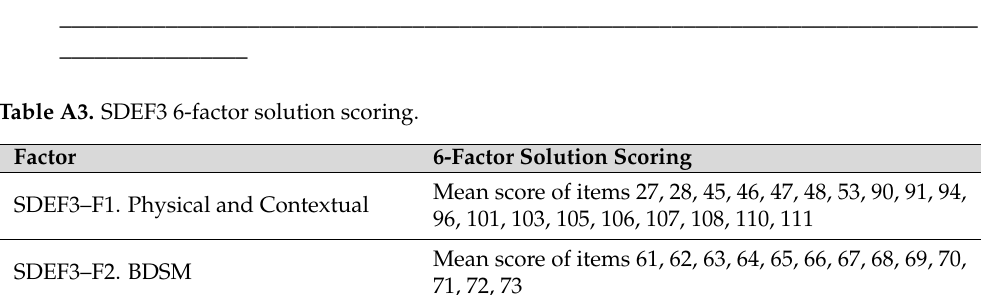
Table A3. SDEF3 6-factor solution scoring.